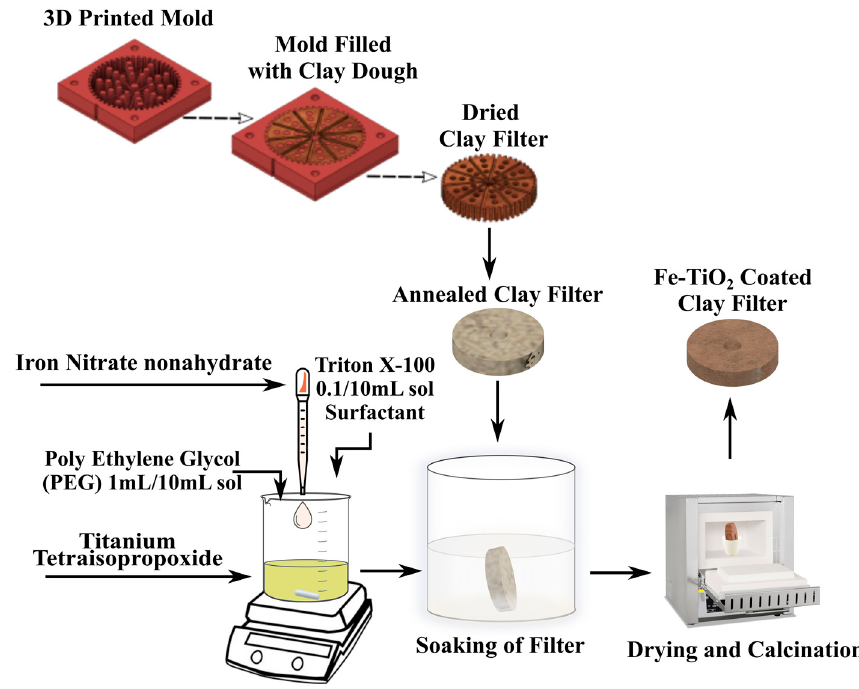
Figure 6. Schematic layout of the preparation of clay filters, precursor solution, and coating